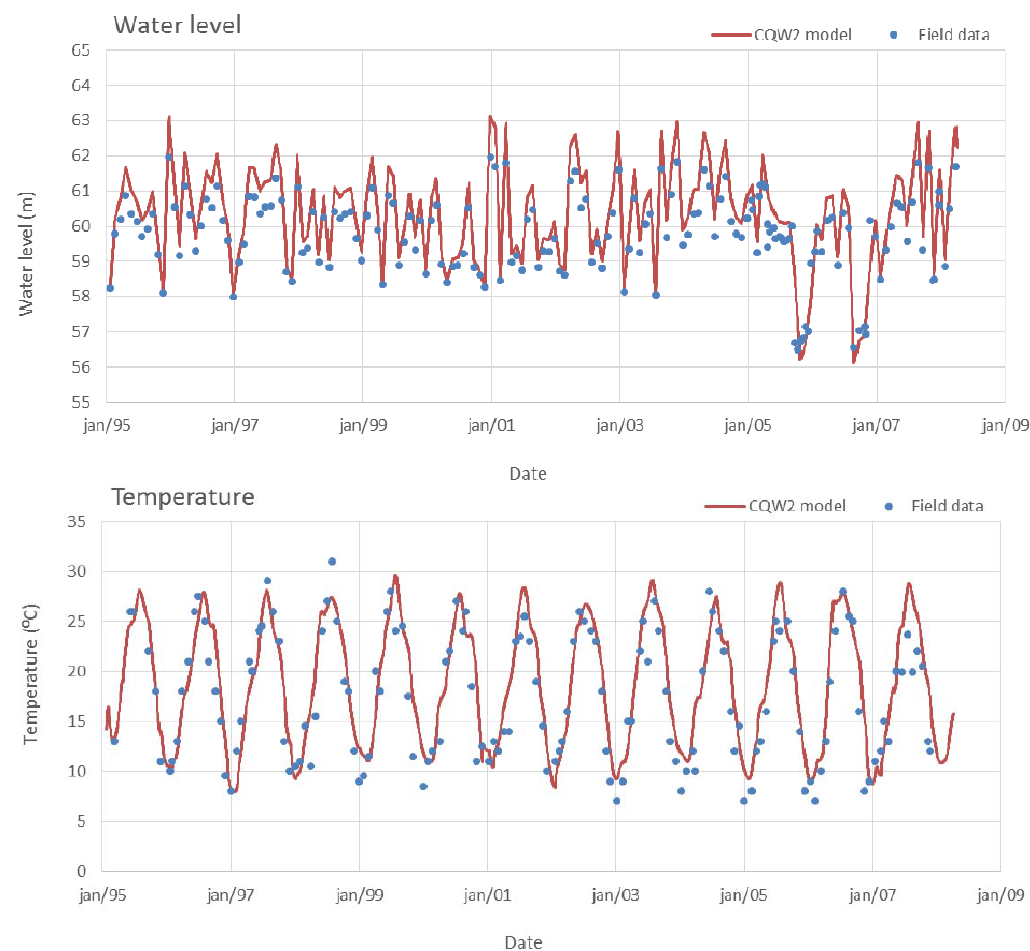
Figure 5. Water level and surface temperature at Torrão reservoir (model estimates and field